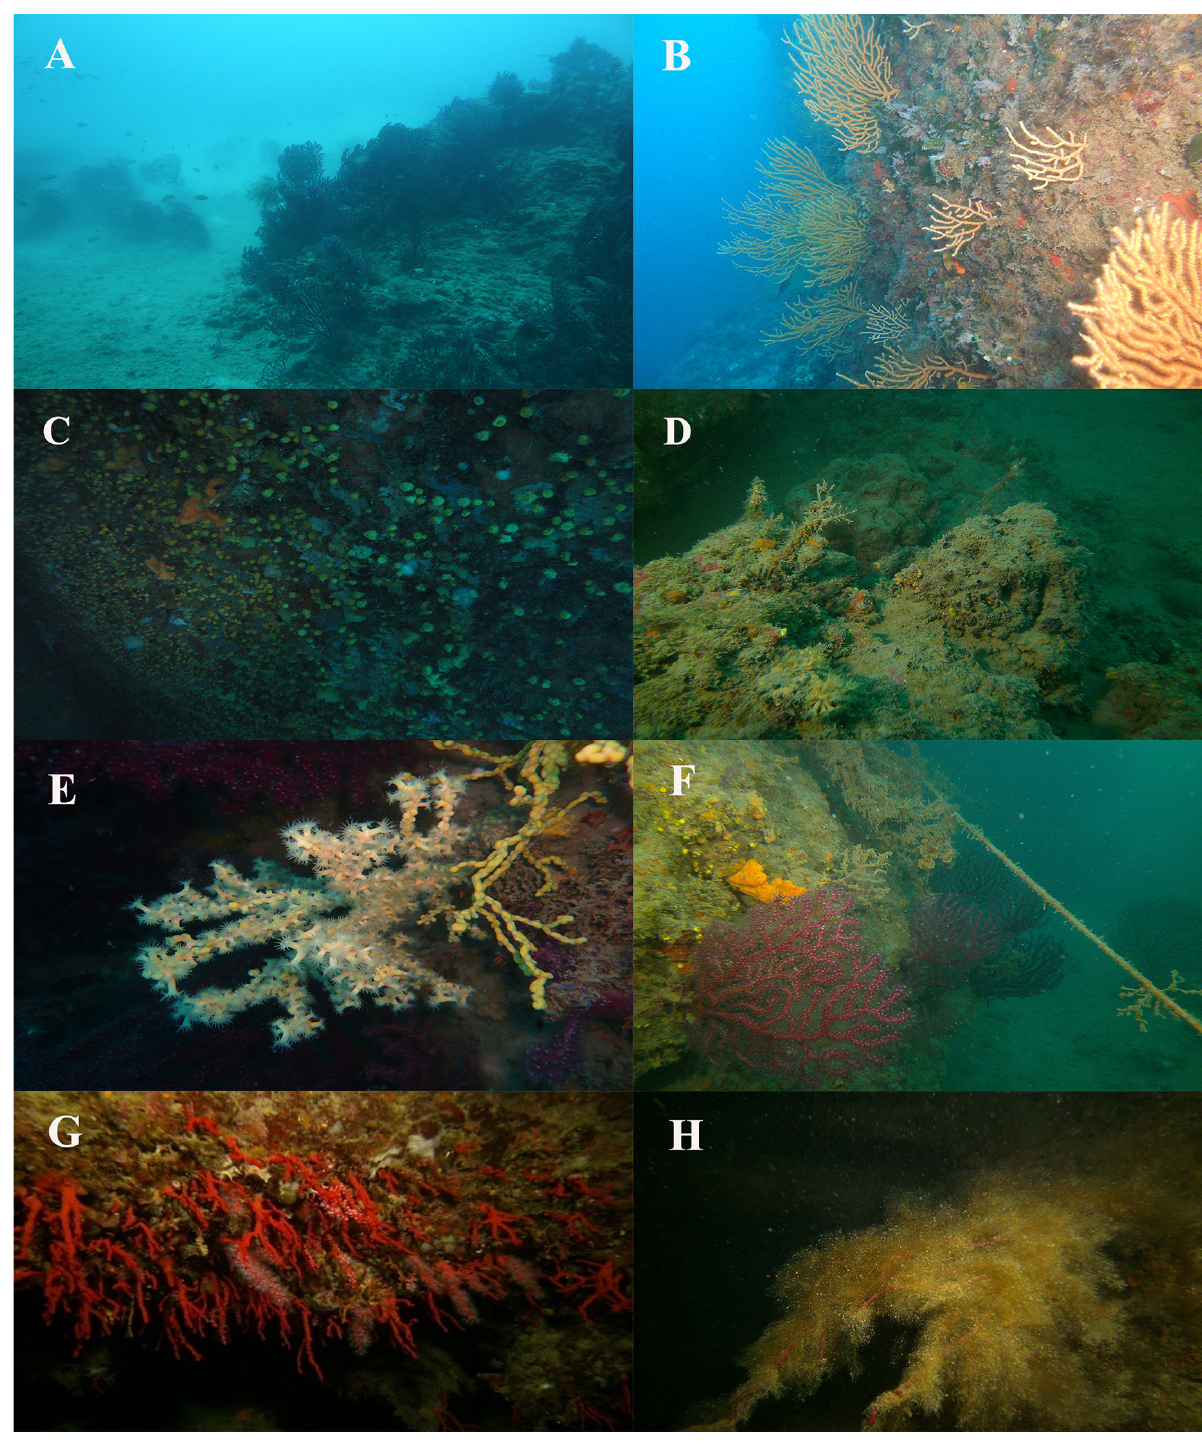
Fig. 6. – Coralligenous assemblages in Liguria. A, facies with Paramuricea clavata thriving on shoal geomorphotype (Corallo Nero, Vado Ligure) at 32 m depth. B, facies with Eunicella cavolini on cliff geomorphotype (Cala dell’Oro, Portofino) at 14 m depth. C, Facies with Lep- topsammia pruvoti (Punta Cervara, Portofino) at 18 m depth. D, facies with massive/erect sponges (Punta Manara) at 36 m depth. E, Savalia savaglia colony (Punta Manara) at 39 m depth. F, presence of lost fishing gears (Punta Manara) at 35 m depth. G, Facies with Corallium rubrum (Punta dell’Altare, Portofino) at 38 m depth. H, presence of mucilaginous event (Punta dell’Altare, Portofino) at 38 m